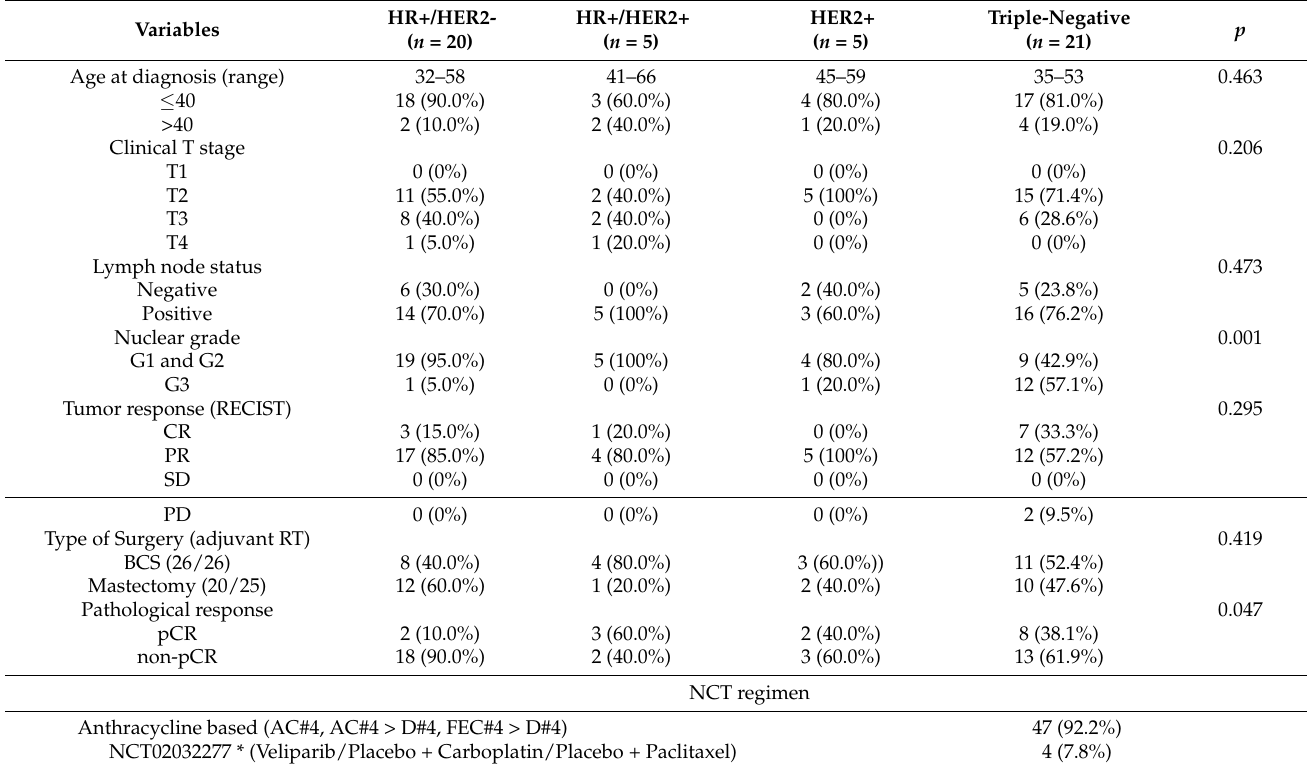
Table 1. Patient characteristics and the NCT